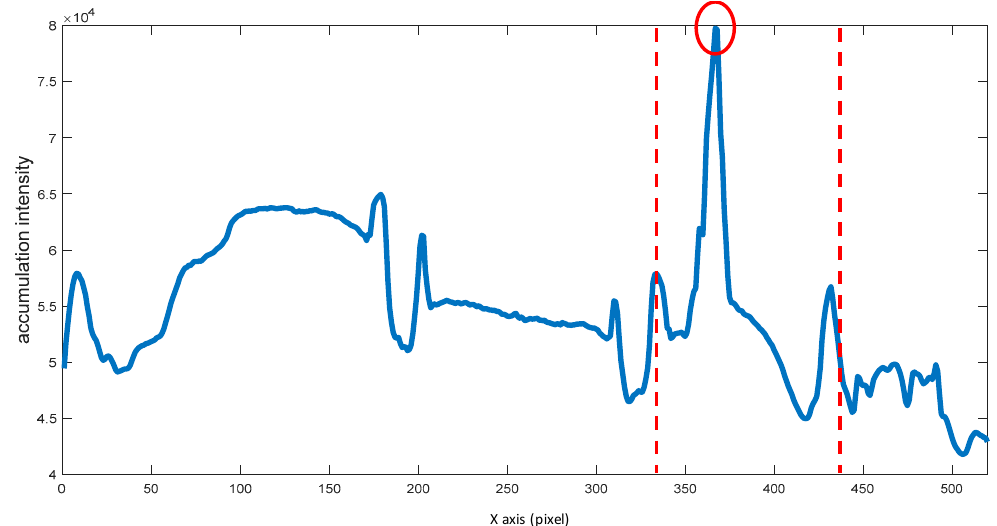
Figure 7. Maximum vertical intensity profile in the x -axis.